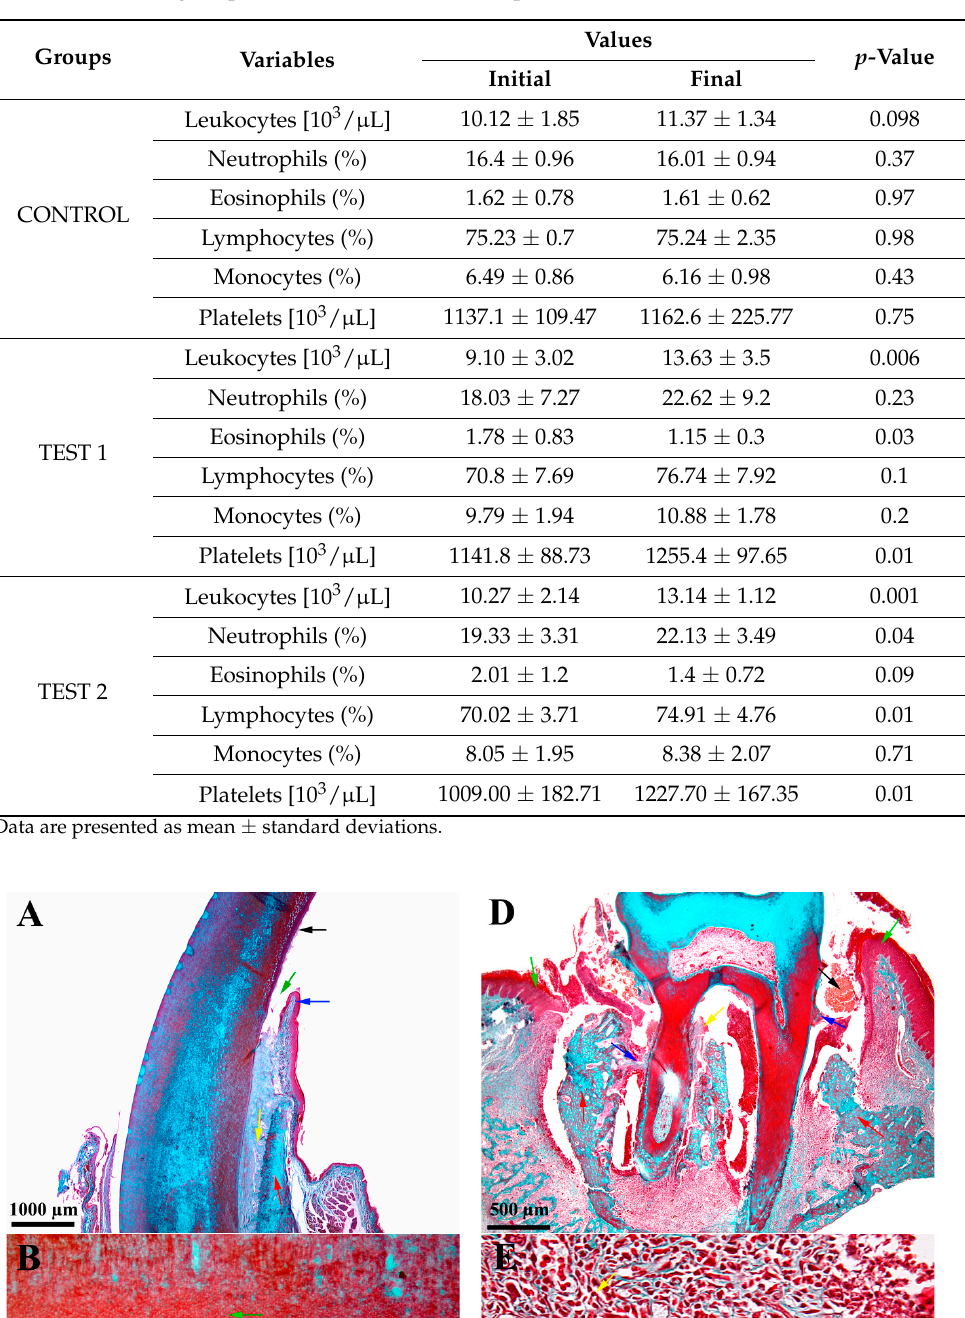
Table 4. Hematological parameters, before and after periodontal disease induction.